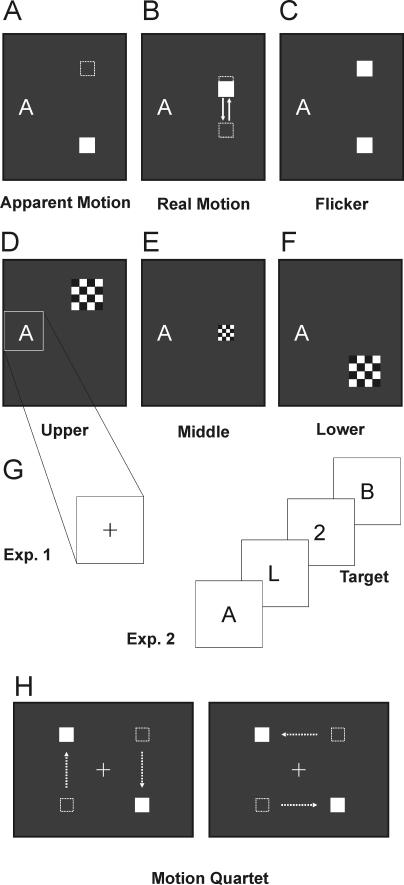
Stimuli Used in Experiments 1 to 3(A) The apparent-motion stimulus consisted of two white squares (size, 1.8°) blinking in alternation (2.3 Hz). The squares were presented at an eccentricity of 9.5° visual angle (distance between squares, 16.5°).(B) The real-motion stimulus consisted of a white square moving in harmonious oscillation (average speed, 66.5°s−1) on the perceived path of apparent motion. The end points of the movement were adjacent to the position of the apparent-motion squares (maximum eccentricity, 8.0°).(C) The flicker control stimulus from experiment 2 was composed of two white squares (1.8°) that were blinking simultaneously at 4.6 Hz.(D–F) For the mapping conditions, high-contrast inverting checkerboards were presented in the upper (D), middle (E), and lower (F) right visual field. Sizes were adjusted according to the cortical magnification factor in V1 to produce activated regions of a similar spatial extent (3.6° for the upper and lower stimuli presented at 9.5° eccentricity, and 1.8° for the middle stimulus presented at 4.7° eccentricity).(G) For the five conditions of experiment 1 (A, B, D–F), subjects saw a white cross at the middle of the screen, which they had to fixate (G, upper part). In experiment 2, a randomly generated stream of letters and digits was presented at 2 Hz in the middle of the screen (G, lower part). Subjects had to fixate the character stream and either passively view the stream or perform a digit-detection task.(H) The motion quartet (experiment 3) was composed of four white squares presented at eccentricities similar to the apparent-motion stimulus. Two squares from diagonally opposite corners were presented at the same time. The motion quartet can be seen in vertical (left part) or horizontal (right part) motion without any changes in the physical characteristics of the stimulus. Subjects had to fixate a white cross in the middle of the screen and had to report the perceived direction of movement (vertical or horizontal).